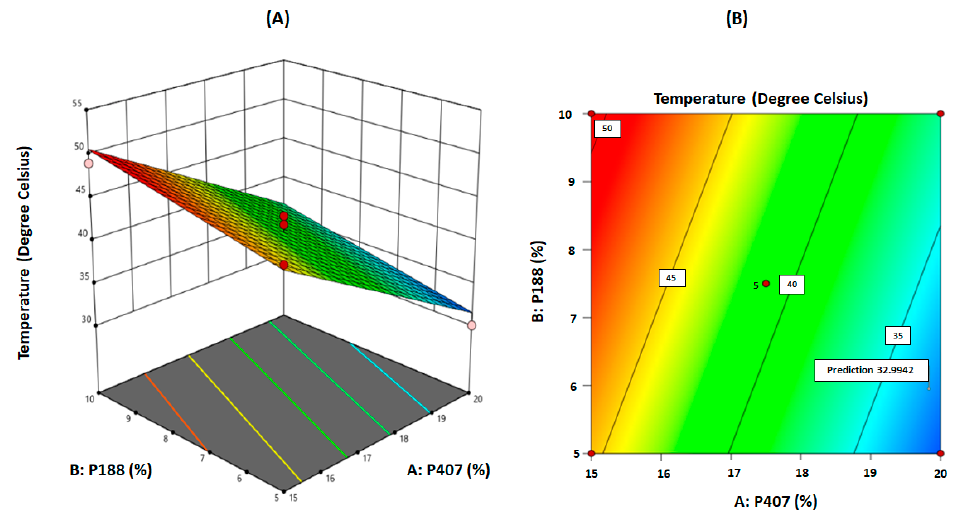
Figure 4. ( A ) Three-dimensional surface plot for gelation temperature as a function of the formula- tion variables. ( B ) Contour plot for gelation temperature as a function of the formulation variables (‘5 ′ refers to five replications on the centre point).